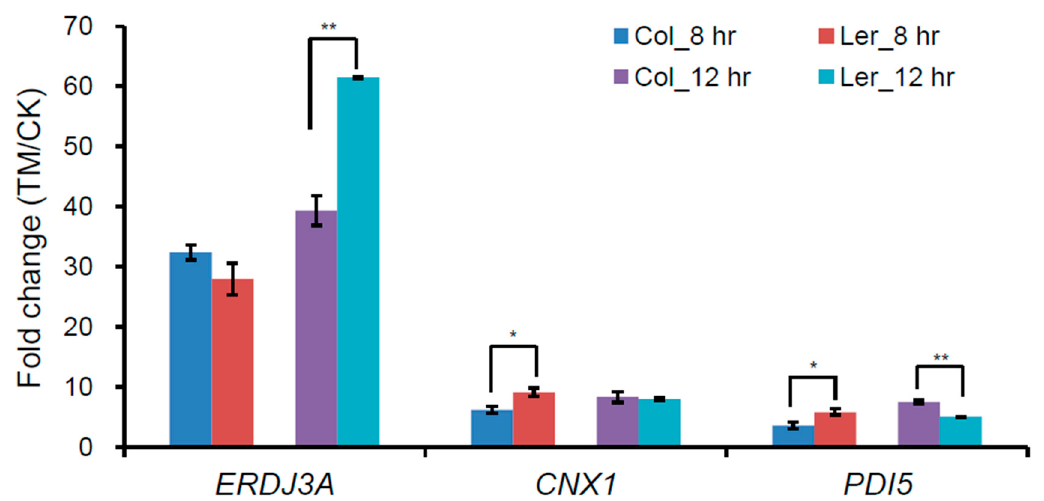
Figure 2. Gene expression analysis of ER stress marker genes in Col and L er plants. Nine-day-old Col and L er seedlings grown on ½ MS plates were treated without or with 5 μ g/mL tunicamycin (TM) for 8 h or 12 h, and total RNA was extracted for quantitative RT-PCR (RT-qPCR). Fold change is the expression level of genes in TM-treated plants relative to that in non-treated (CK) plants, both of which were normalized to that of the control ACTIN . Error bars represent SE (n = 3). Asterisks indicate significance levels as compared with two ecotypes in t -test. (*, p < 0.05; **, p < 0.01). Table 1. Summary of number of differentially expressed proteins for each comparison.